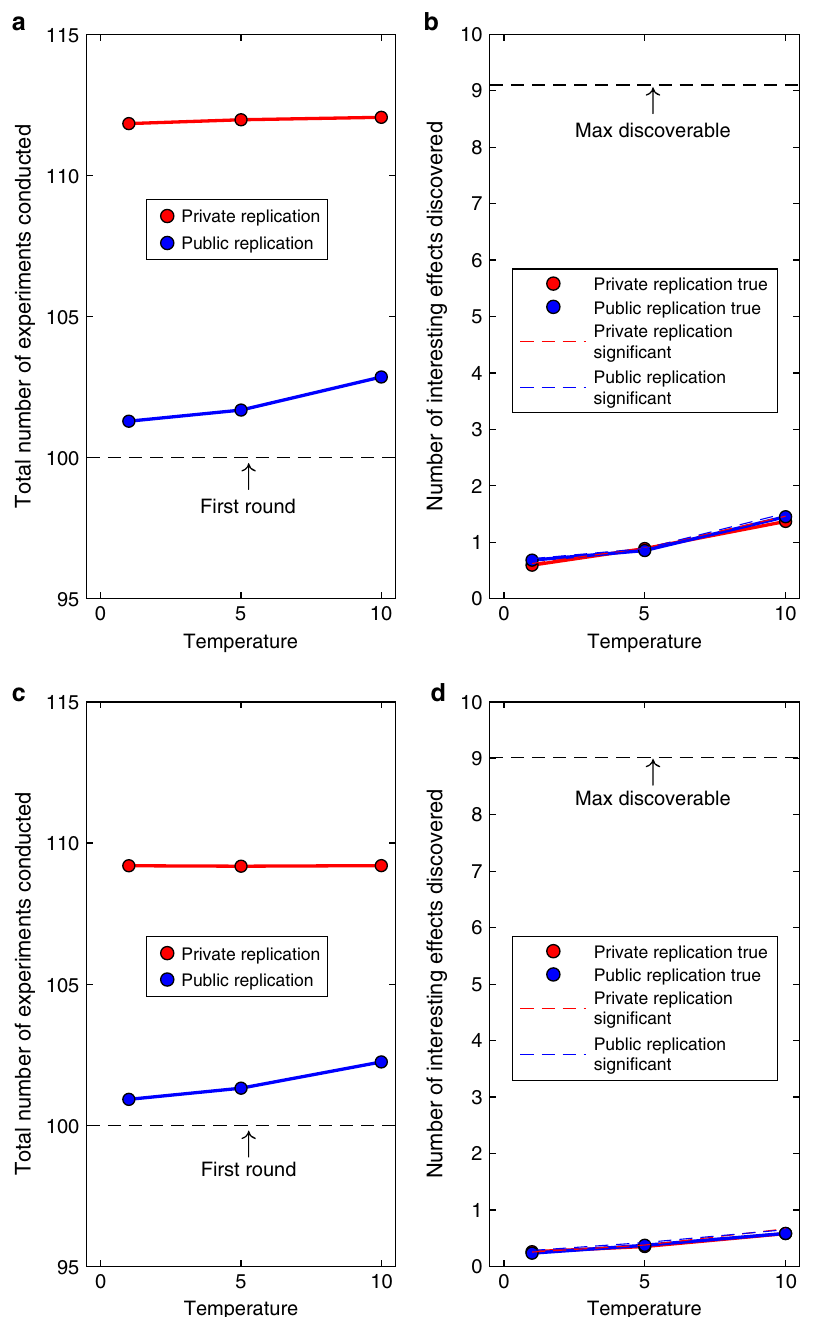
Fig. 4 Scienti fi c achievements and costs for discovery-oriented research, using frequentist analysis. Power was 0.8 a , b or 0.5 c , d . a and c show the cost (total number of experiments conducted) to generate the knowledge (true effects discovered) shown in b and d . Temperature refers to the temperature of the logistic decision function (Methods section). Successful replications are identi fi ed by dashed lines in b and d . Successful replications that are also true (i.e., the null hypothesis was actually false) are identi fi ed by plotting symbols and solid